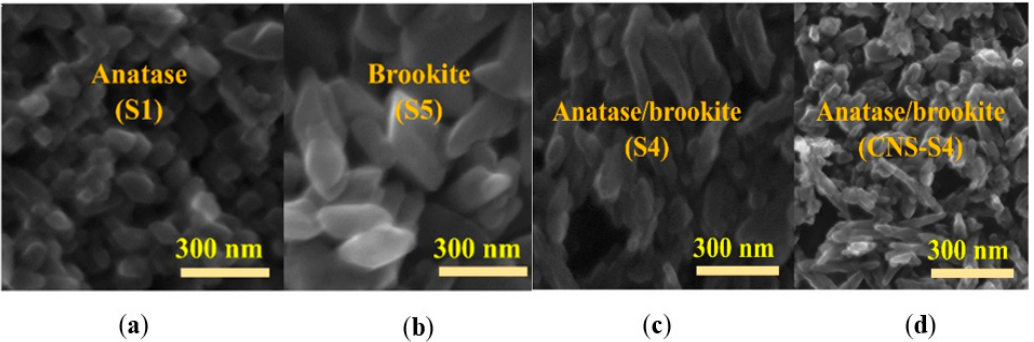
Figure 1. XRD patterns of: ( a ) S1, S2, S3, S4 and S5; and ( b ) S4 and CNS-S4.